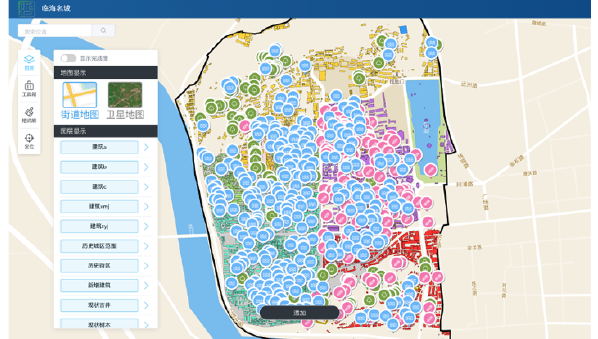
Figure 13 . Collection Results of Linhai Historic City.